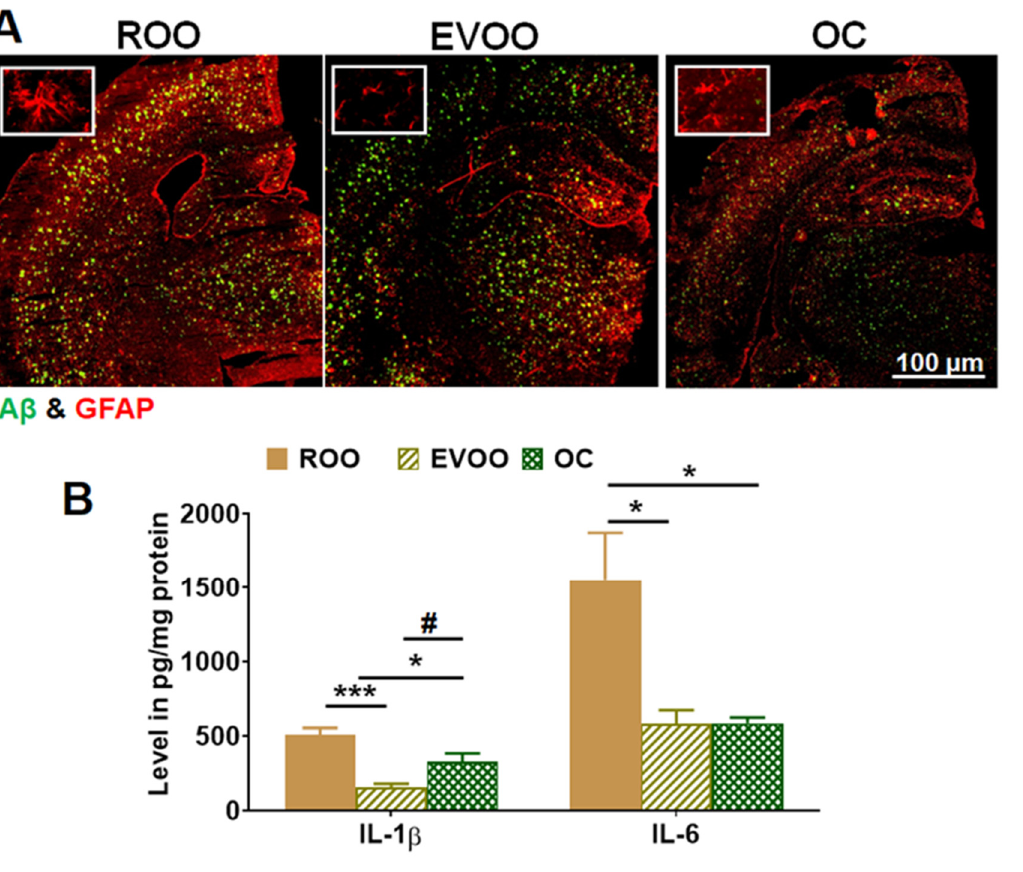
Figure 5. Effect of EVOO and OC consumption (0.5 μ g/kg) for three months on astrocytes activation and cytokines in 5xFAD mouse brains. ( A ) Representative brain sections stained with anti ‐ GFAP antibody and anti ‐ A β (6E10 antibody) to detect activated astrocytes (seen at higher magnification in the closed inserts, 500 μ m). ( B ) Brain levels of the cytokines IL ‐ 1 β and IL ‐ 6 as determined by ELISA (n = 6 mice per group). Values were normalized to the ROO group (1.0). Data are presented as mean